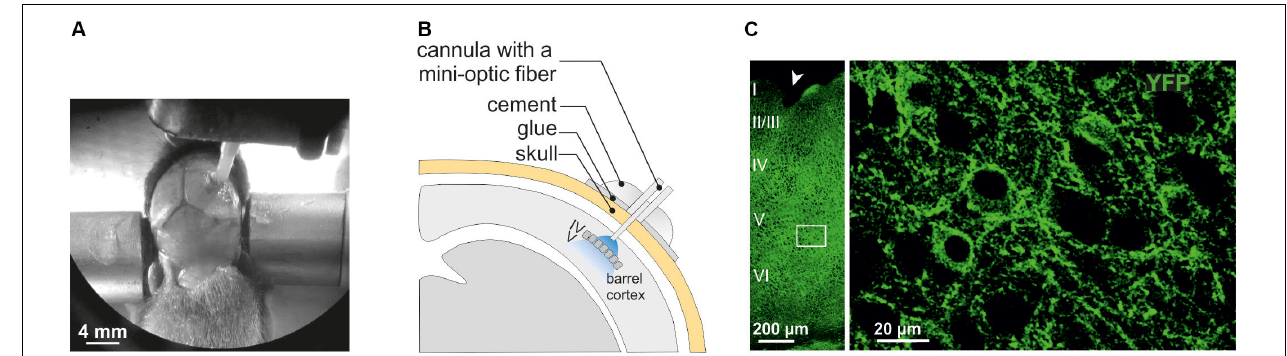
FIGURE 1 | Surgery for in vivo optogenetic stimulation of interneurons of the somatosensory cortex in mouse pups. (A) An anesthetized PN10 mouse holding the implant and fixed in a stereotaxic apparatus is shown. Before to place the mini-optic fiber the skull is covered with two layers of glue. In this example, the skin of the animal was more widely incised for visibility on the picture. (B) Scheme of the mini-optic fiber implanted at the surface of the somatosensory barrel cortex. (C) Confocal images of ChR2-expressing interneurons in layers from I to VI (left; low magnification) and in layer V (right; high magnification of the white square in the left) of the barrel cortex of a Nkx2.1 Cre :ChR2-YFP Lox / + mouse at PN10. ChR2 expression driven by the Nkx2.1 promoter is detected by the YFP reporter (green). The arrowhead indicates a small lesion induced when removing the optic fiber of the pup after perfusion. It allows us to precisely locate the place of the mini-optic fiber.